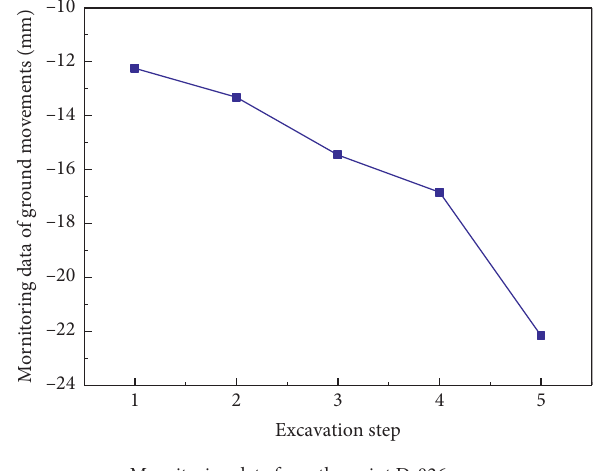
Figure 3: Time-series monitoring data of tunneling-induced ground